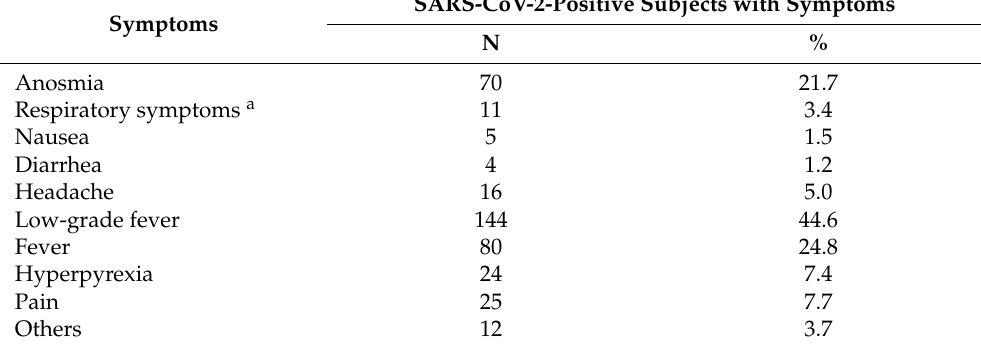
Table 2. Symptoms among 323 subjects with symptomatic SARS-CoV-2 infection in the Community of “San